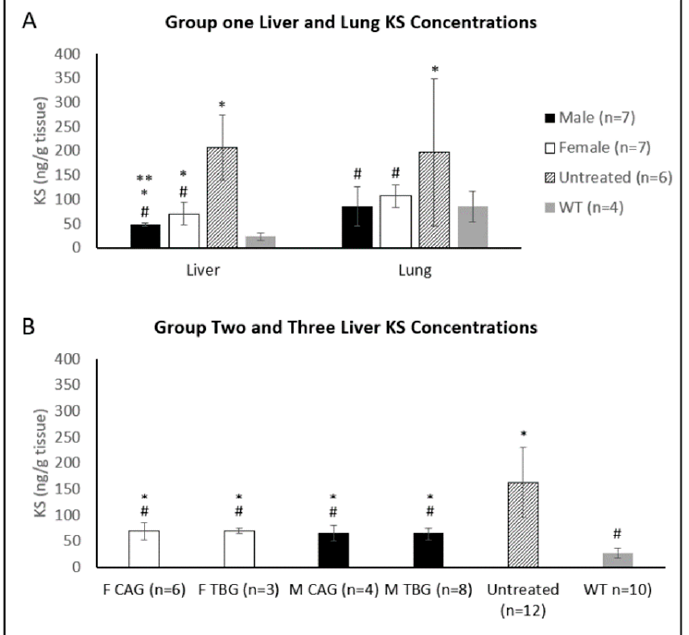
Figure 6. ( A ) KS concentrations in liver and lung tissue for Group One (mice treated with the TBG promoter) and ( B ) KS concentrations in liver for Groups Two and Three (mice treated with the CAG and TBG promoter, respectively). Error bars display standard deviation. * indicates a two-tailed t -test p -value of <0.05 compared to the WT cohort. ** indicates a two-tailed t -test p -value of <0.05 compared to the opposite sex. # indicates a two-tailed t -test p -value of <0.05 compared to the untreated cohort. KS: keratan sulfate, TBG: thyroxine-binding globulin, CAG: a ubiquitous promoter including a cytomegalovirus enhancer element, a chicken β -actin promoter, and an intron., F: female, M: male, WT: